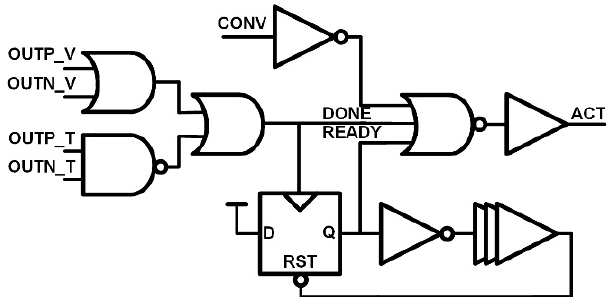
Figure 12. Schematic of the asynchronous timing controller.